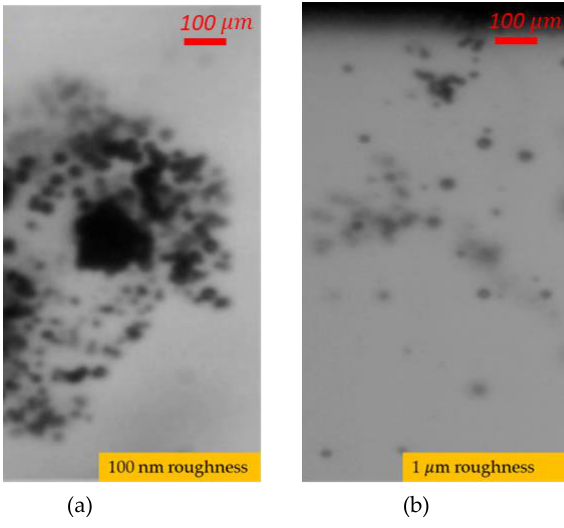
Figure 9. The cavitation bubbles at 40 kHz. ( a ) Multi-bubble cloud formation on a smooth surface with 100 nm roughness; ( b ) Disorganized bubbles with diminution of cavity length on a rough surface with 1 µm roughness.